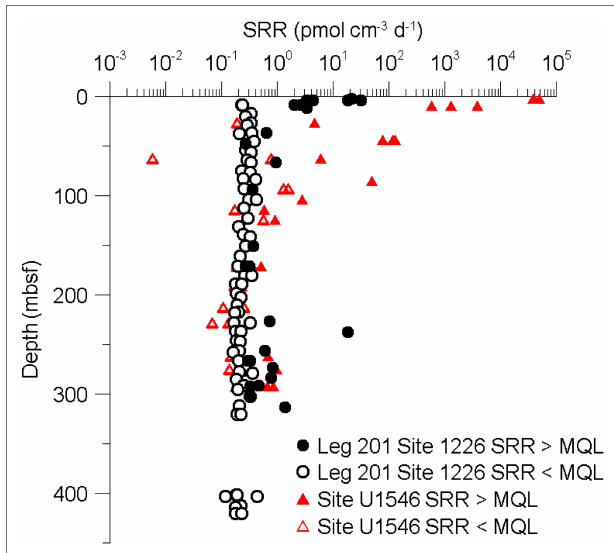
FIGURE 5 | Comparison of SRR in subsurface sediments from the tropical eastern Pacific Ocean (ODP Leg 201, Site 1,226) and Site